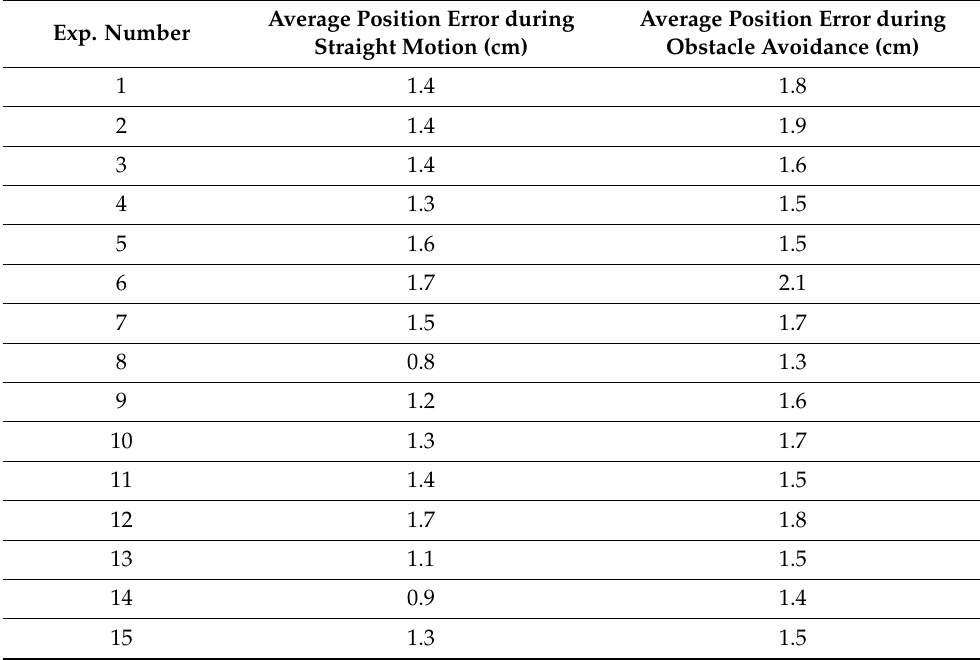
Table 2. Average position